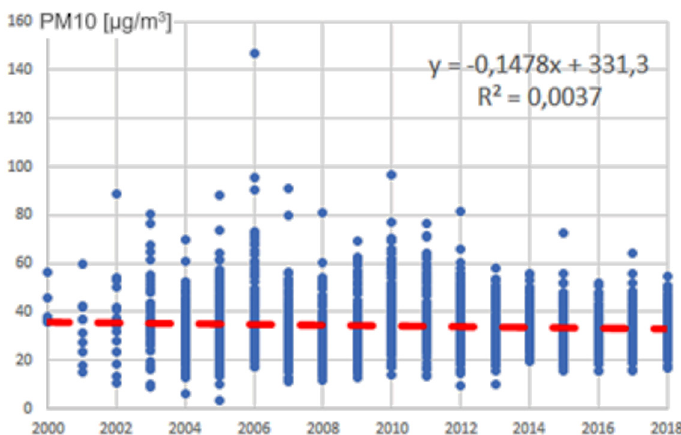
Fig. 5. Averaged annual results for entire Poland: no significant linear trend. Blue points: averaged PM10 measurements (µg/m3) for particular points and years. Red dotted line: a regression line